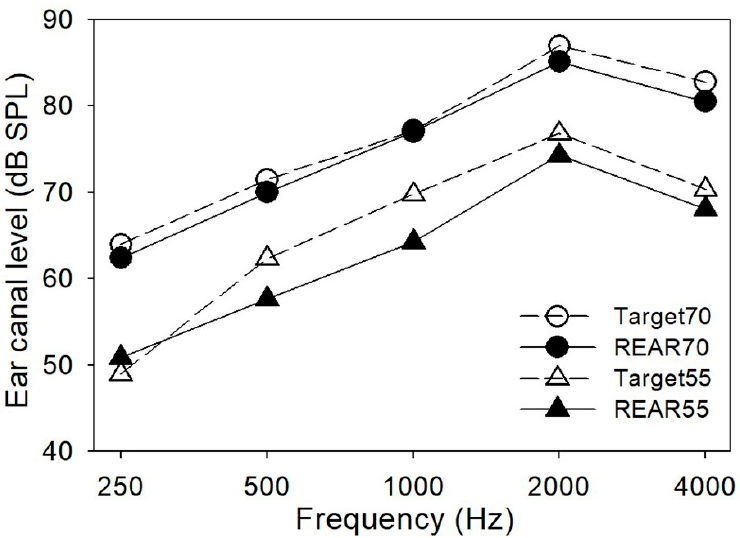
Figure 2. Mean real-ear-aided response (REAR) values for 55 dB SPL and 70 dB SPL speech com- pared to the NAL-NL1 targets across the 34 participants (68